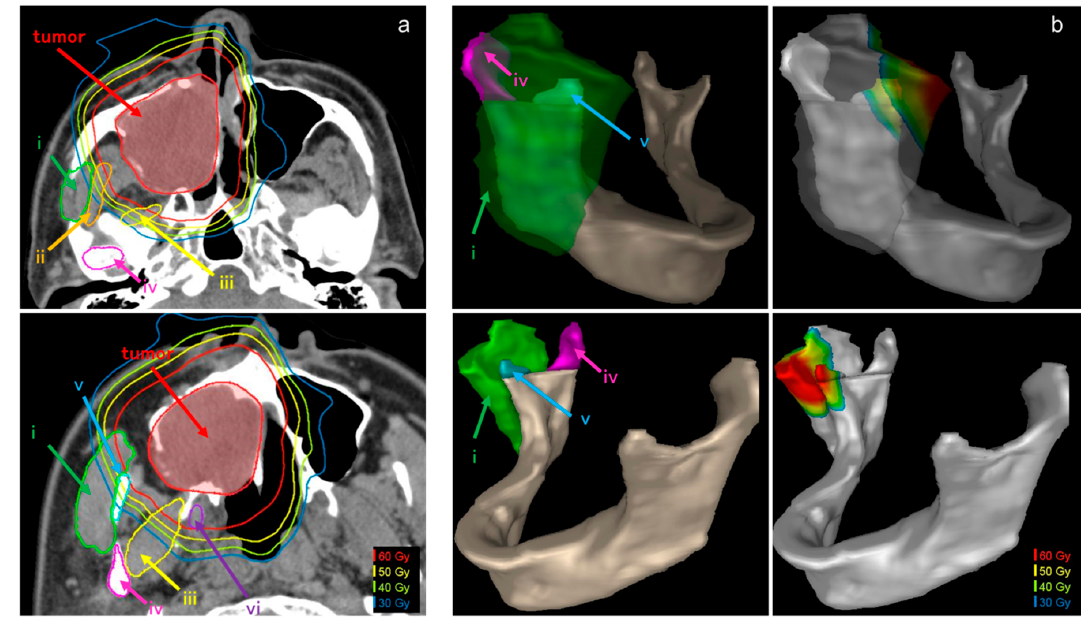
Figure 2. Representative case of computed tomography images of a tumor and temporomandibular joint-related muscles and bones and a 3-dimensional image of the mandible. ( a ) Computed tomography images of a tumor and temporomandibular joint-related muscles and bones. This patient with adenoid cystic carcinoma of the right maxillary sinus (T3N0M0). ( b ) The 3-dimensional image of the mandible with masseter muscle, mandible head, and coronoid process. The left figure shows the anatomical position. The figure on the right shows the dose distribution. (i) Masseter muscle, (ii) temporal muscle, (iii) lateral pterygoid muscle, (iv) mandible head, (v) coronoid process, and (vi) medial pterygoid muscle and tumor.